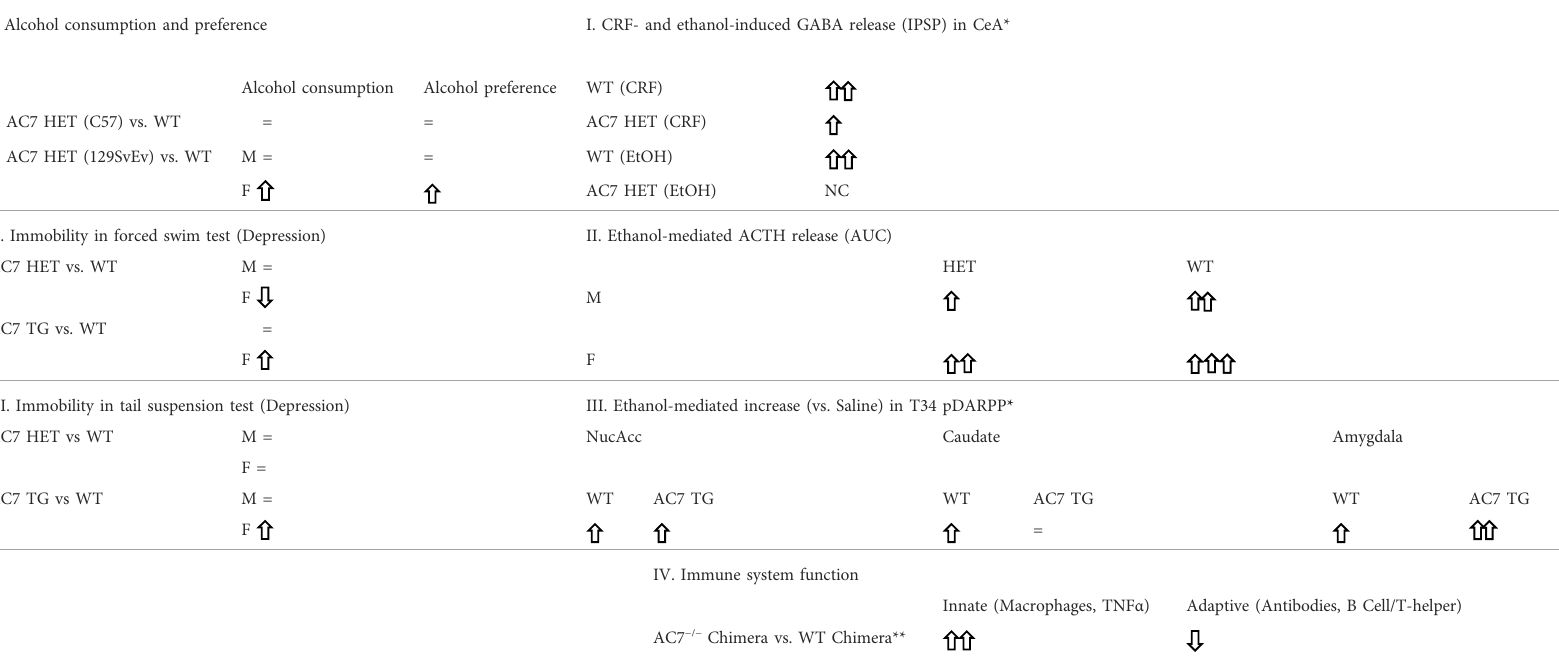
TABLE 1 Phenotypes of WT, AC7 HET, and AC7 TG